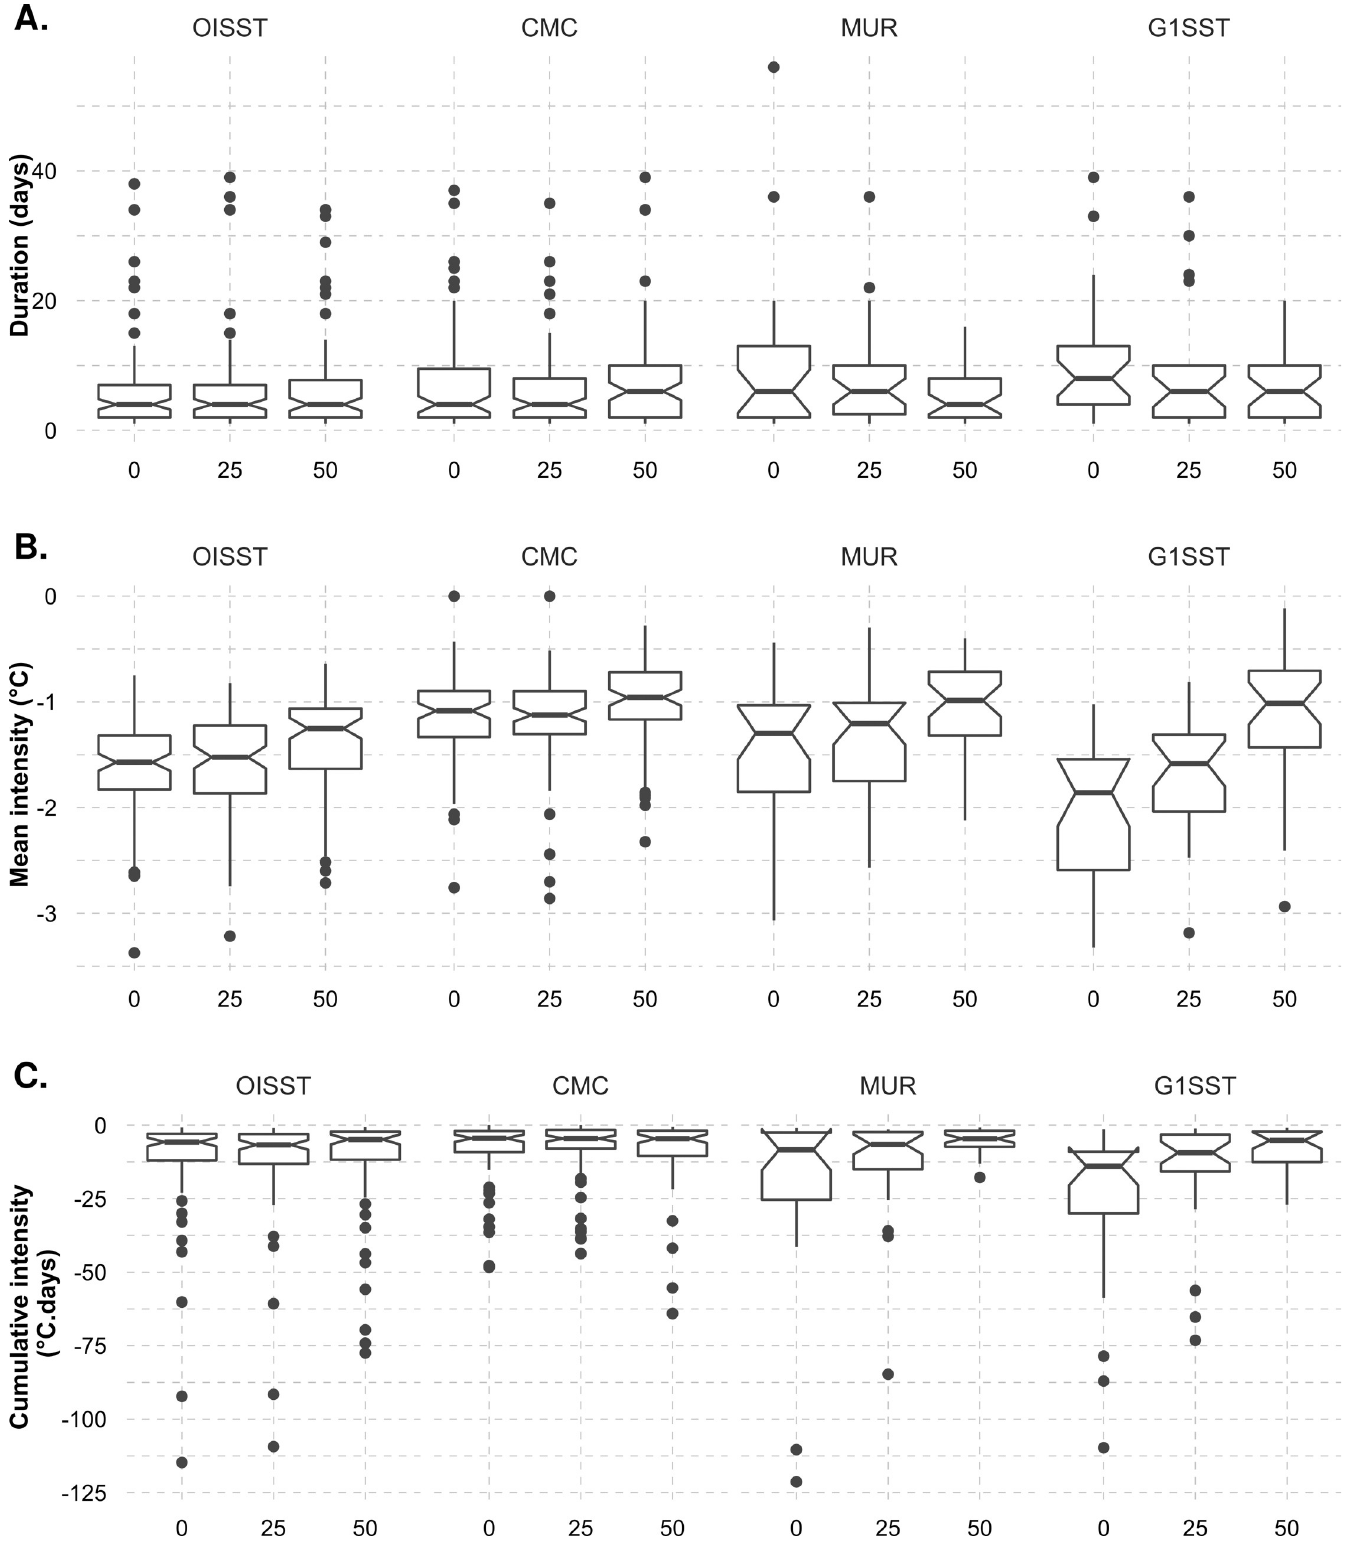
Fig 3. Boxplots showing the A) duration, B) mean intensity, and C) cumulative intensity for each of the upwelling signals detected at various distances (km) from the shore for the four satellite products during summer months (December, January, and February), over a six-year period. The properties of the boxplots are as in Fig 2.